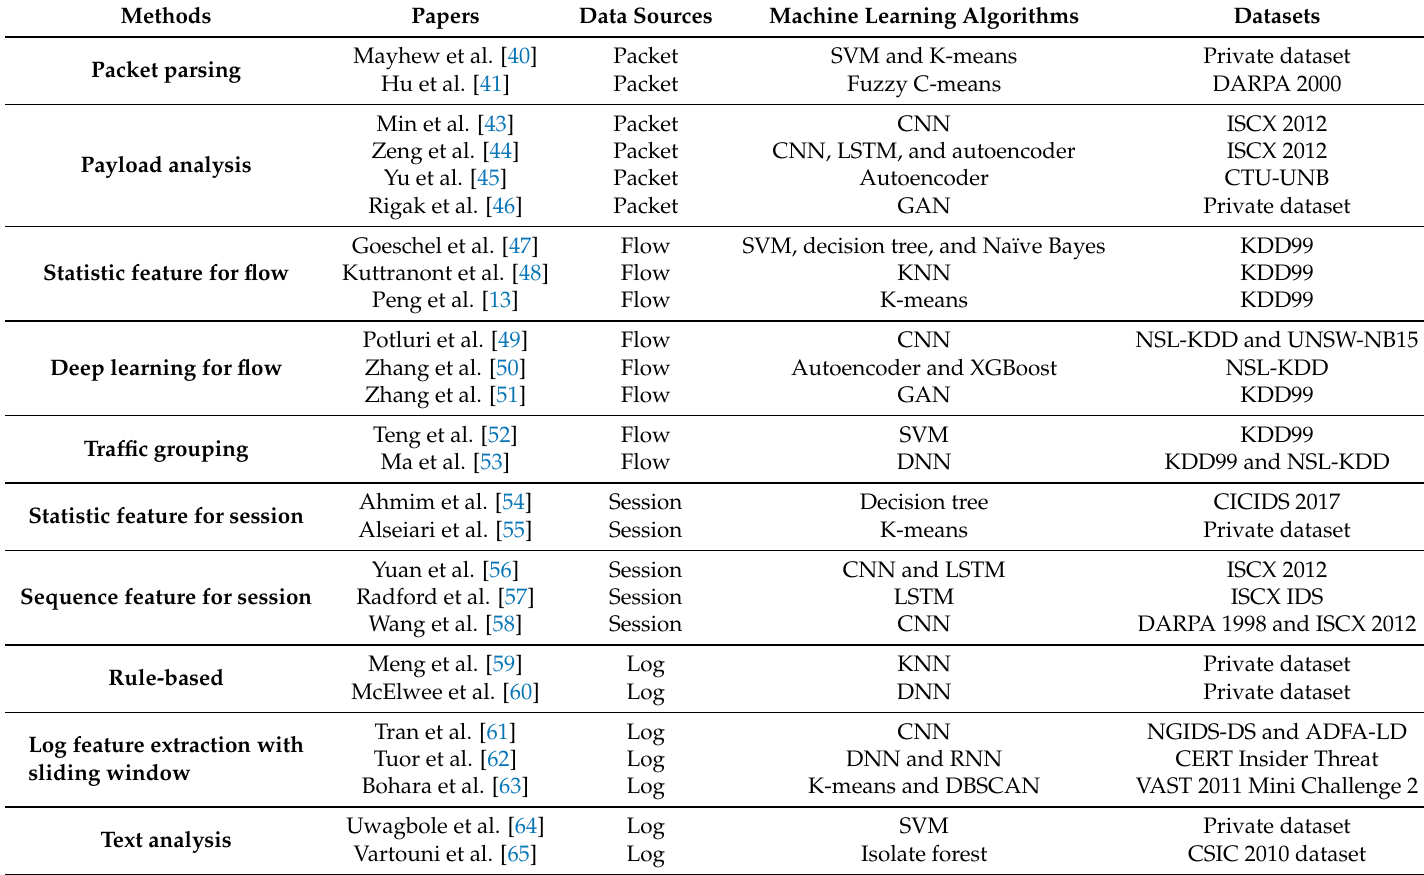
Table 5. Methods and papers on machine learning based